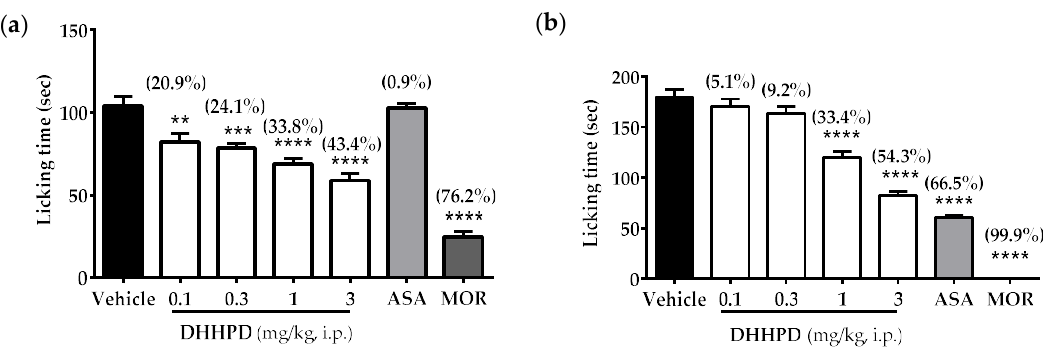
Figure 3. Effect of DHHPD against 2.5% formalin-induced paw licking test in mice. ( a ) Early/neurogenic phase; ( b ) Late/inflammatory phase. Each column represents the mean ± SEM ( n = 6). The asterisks (*) denote the significance level as compared to the vehicle group, ** p < 0.01, *** p < 0.001, **** p < 0.0001 by one-way ANOVA followed by Dunnett’s post hoc test. Mice were administered with vehicle (10 mL/kg, i.p.), acetylsalicylic acid (ASA, 100 mg/kg, i.p.) and DHHPD (0.1, 0.3, 1 and 3 mg/kg, i.p.).